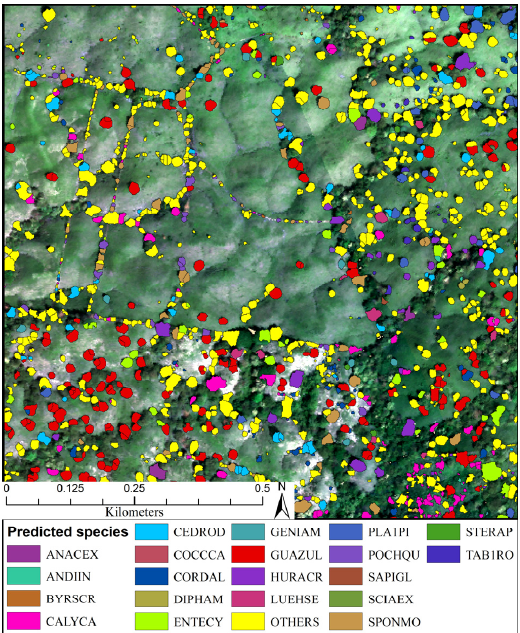
Figure 7. Predicted species of agricultural tree crowns on subset of the landscape. Crown predictions are overlaid on true-color 2-meter resolution image. Polygons are colored by their predicted species. Full species names for each species code are given in Table 2.